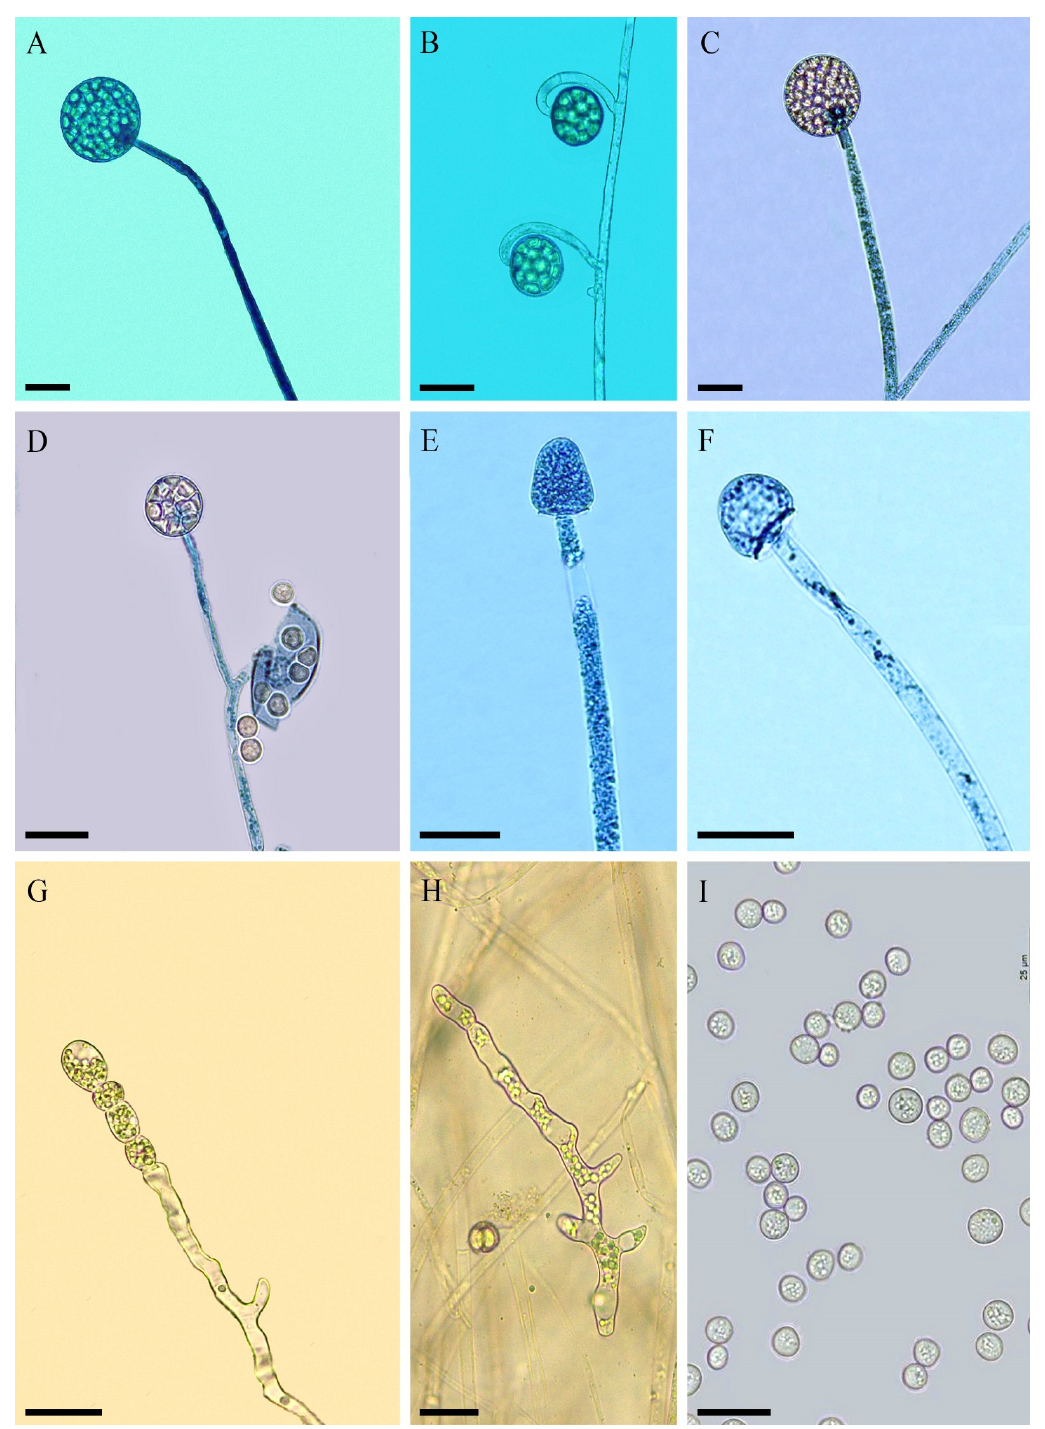
Figure 2. Backusella brasiliensis (URM 8395): ( A ) sporangiophore with sporangium; ( B ) pedicellate sporangiola arising from the sporangiophore; ( C ) sporangiophore branch with sporangium; ( D ) short-branched sporophore bearing only sporangiola; ( E,F ) sporangiophore with columella; ( G ) terminal chlamydospores; ( H ) giant cell; and ( I ) sporangiospores. Scale bars = 25 μ m. Habitat: Soil Distribution: Pernambuco, Brazil. Specimen examined: BRAZIL, Pernambuco, Mimoso (08°39 ′ 688 ″ S 036°90 ′ 013 ″ W), soil, 2019, C.L.F. Lima (holotype URM 94839, ex-type URM 8395). Media and temperature tests: On PDA, at 10 °C, slow growth (3 cm diameter in 144 h) with poor sporulation; at 15 °C, better growth (6 cm in 120 h) than that at 10 °C with good sporulation; at 20 °C, good growth (7 cm in 120 h) with good sporulation; at 25 °C, better growth (9 cm in 96 h) with good sporulation; at 30 °C, good growth (9 cm in 144 h) and good sporulation; at 35 °C, slow growth (2 cm in 120 h) with lack of sporulation; and at 40 °C, lack of growth. A similar growth pattern was observed on MEA and PDA at all temperatures.